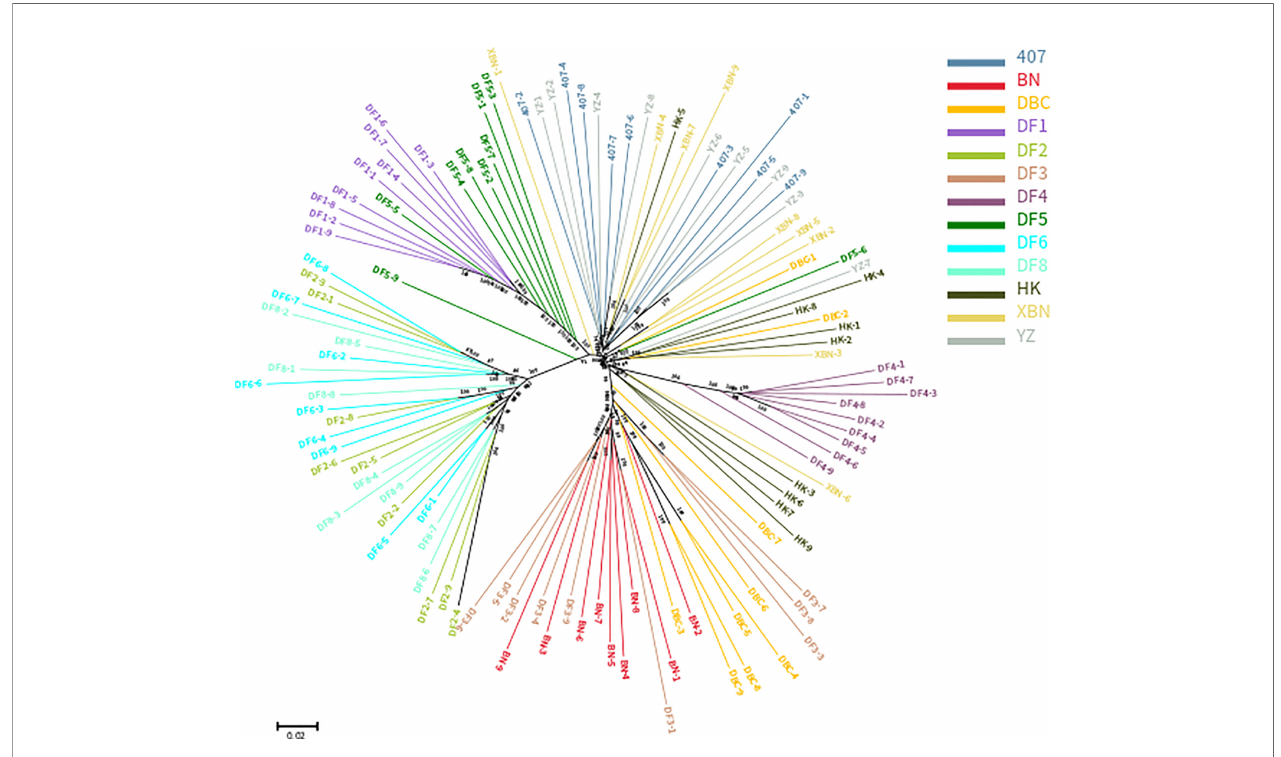
FIGURE 2 | Phylogenetic tree of the 13 cultivars based on the analysis of 340,398